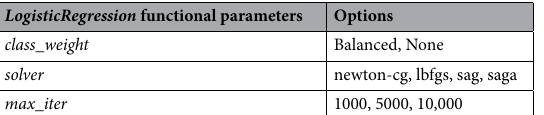
Table 2. Functional parameters tested for the logistic regression approach model optimization.